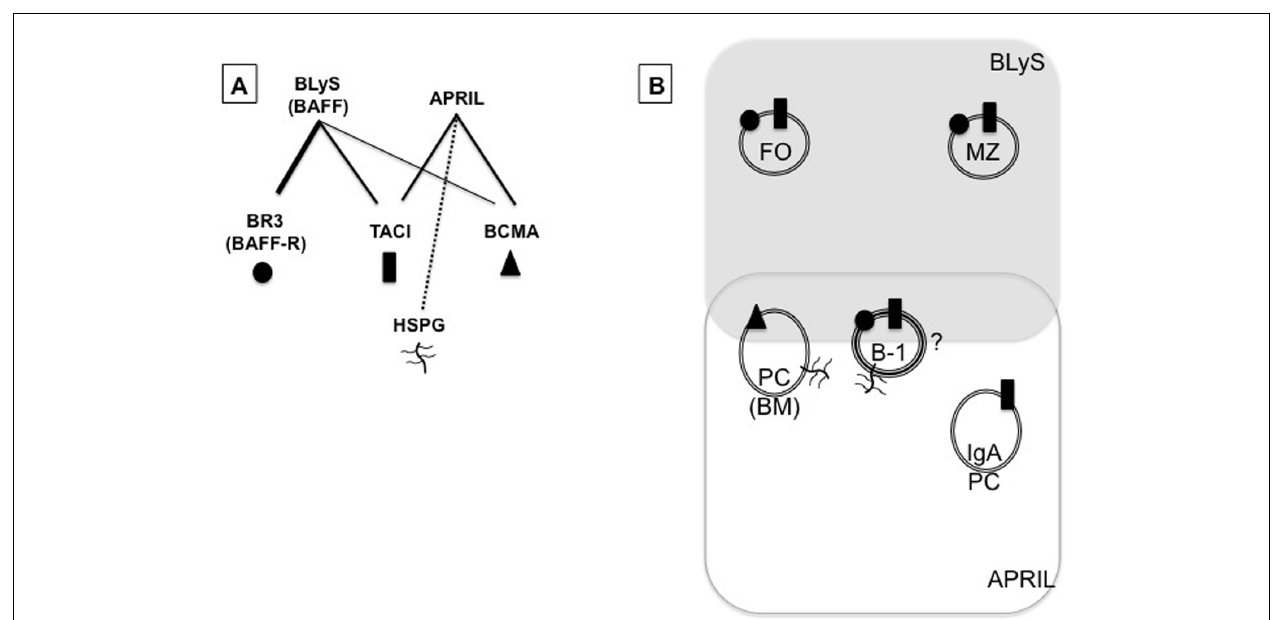
zone (MZ) B cells is governed by BLyS signaling through BR3, yet cells of these subsets also expressTACI, and there is evidence that APRIL signaling throughTACI is key for isotype switching to IgA following antigen encounter. BCMA is required for long-lived plasma cell (PC) maintenance in bone marrow (BM) likely by APRIL signaling through this receptor, but BLyS may also play a role. B-1 B cell maintenance may require BLyS in the spleen but APRIL in the peritoneal